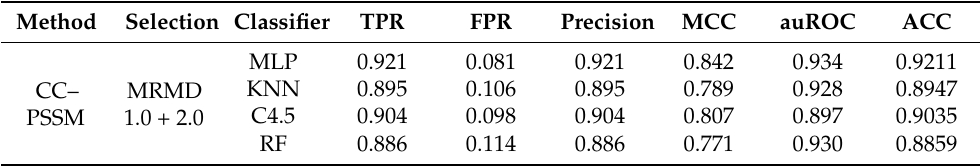
Table 6. MRMD1.0+MRMD2.0 recognizes the comparison of the two–dimensional key features represented by CC–PSSM under other classifiers.